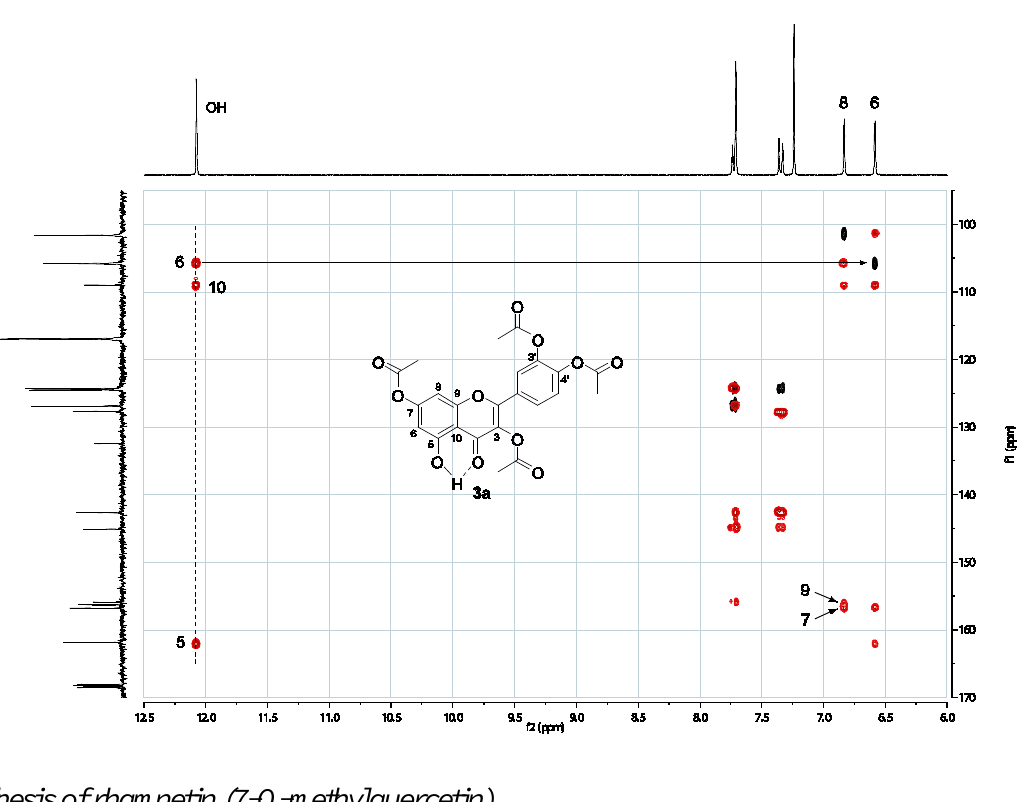
Figure 2. HSQC (black) and HMBC (red) spectra of 3a